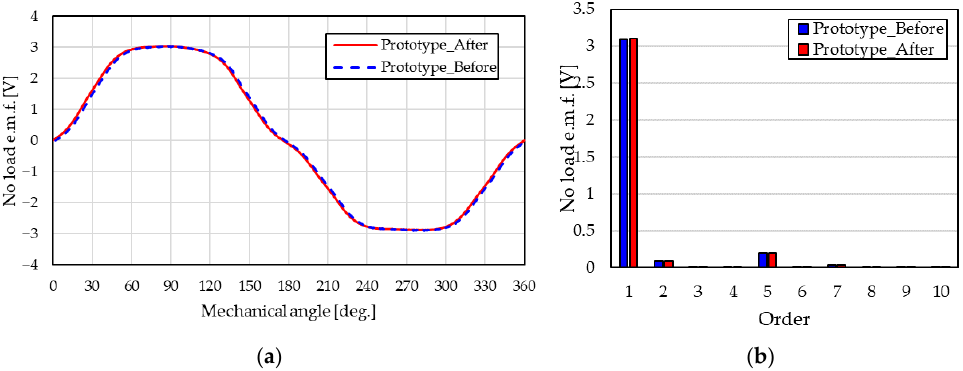
Figure 26. U-phase back e.m.f. of the prototype motor before and after the experiment at 1000 r/min: ( a ) waveforms; ( b ) FFT results.